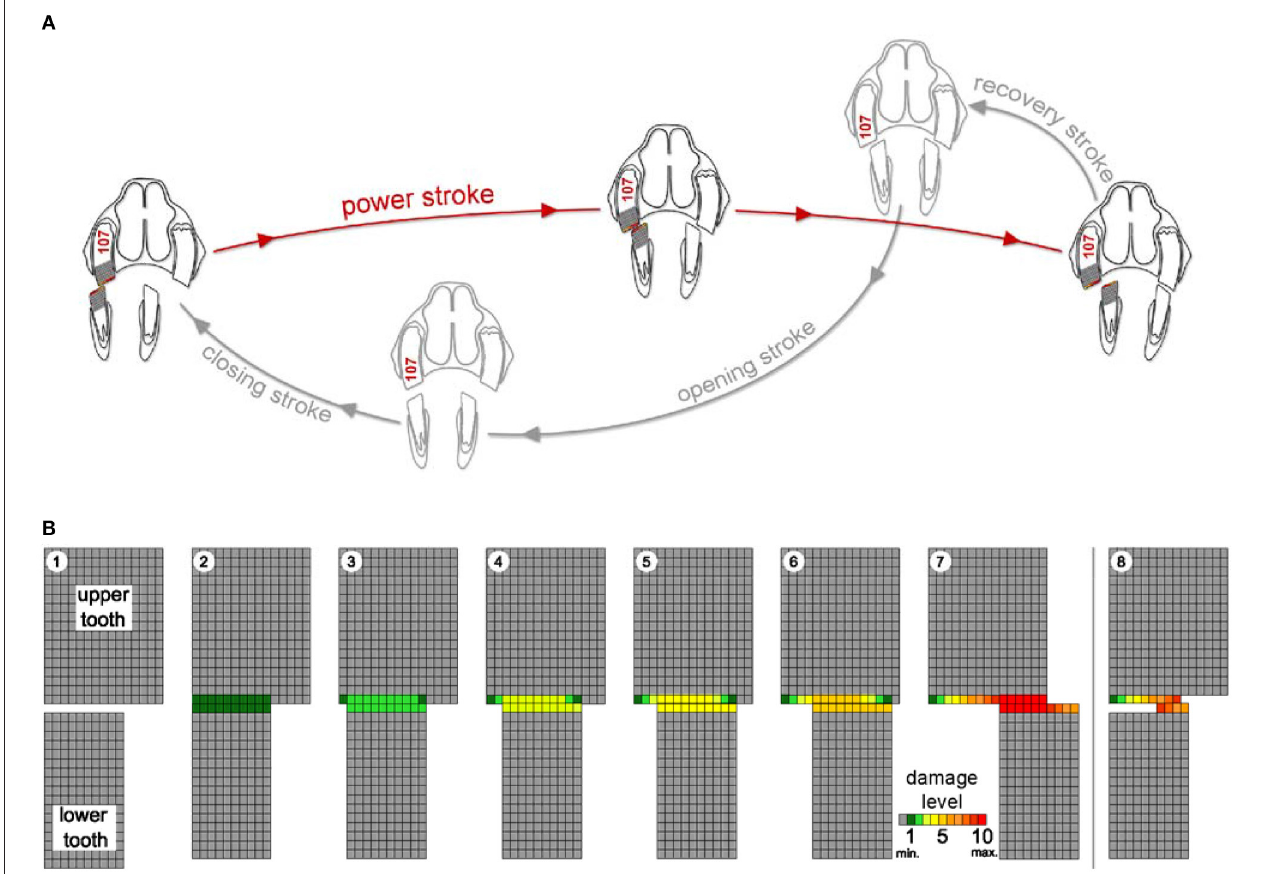
FIGURE 1 | Schematic drawing of the chewing cycle (A) and a simulation of occlusal aspects of the teeth (B) illustrating the damage process as loss of pixel-by-pixel due to abrasional contacts. Upper and lower cheek teeth are represented as a two-dimensional rectangular matrix of a defined number of pixels. During the power stroke (steps 1 to 7), the lower cheek tooth moves in lingual direction across the upper cheek tooth pixel by pixel from left to right. Damage levels are given as number of touches per pixel (from minimum (min.) 0 = gray to maximum (max.) 10 = dark red). Step 8 indicates the starting point of the next power stroke. After every step, the damages of those pixels that are in contact with the antipode pixels are increased. When pixel damage exceeds the defined maximum damage value (10, dark red), it is erased (white).